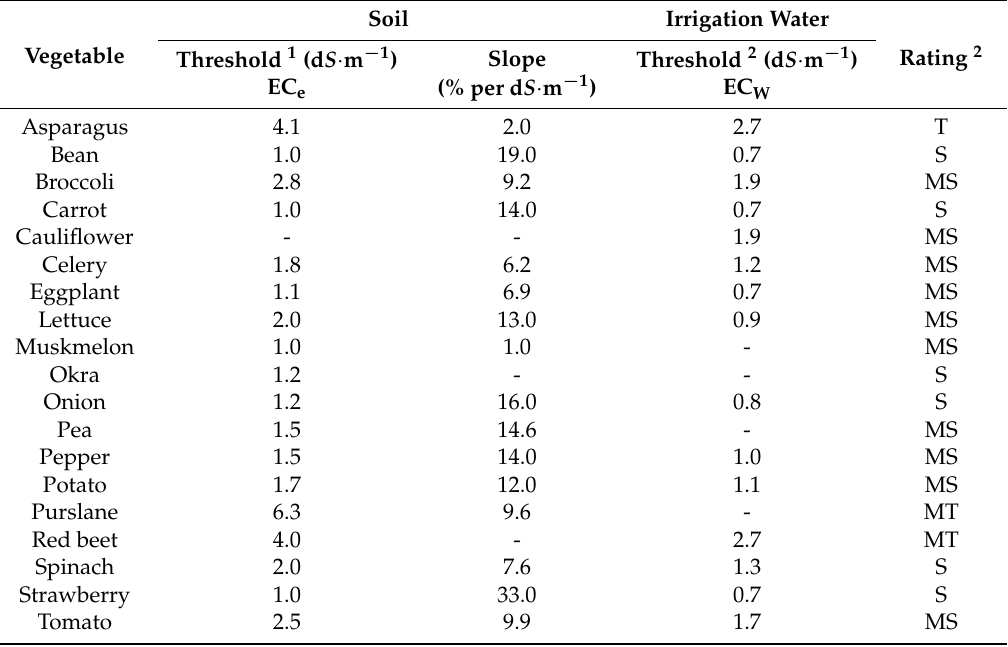
Table 2. Salt tolerance of vegetable crops as determined by soil salinity (EC e ) and irrigation water salinity (EC W